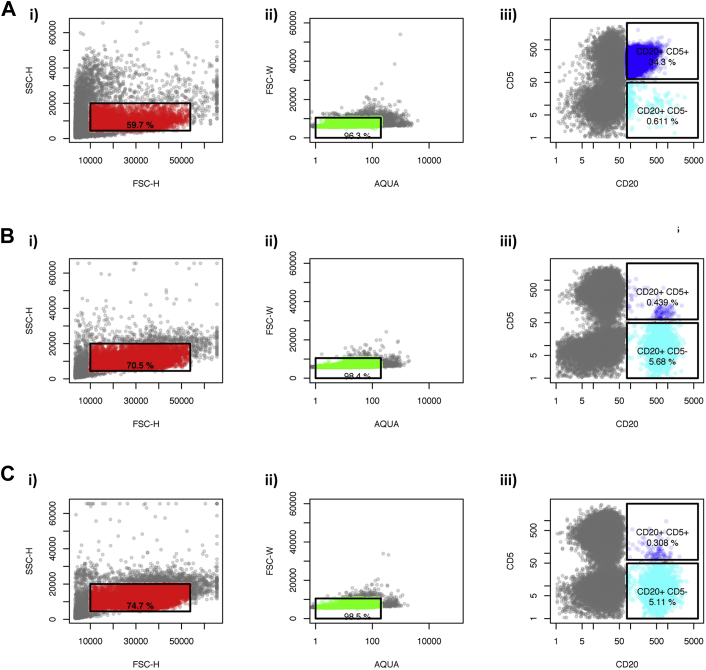
Bulk-cell flow sorting of CD5high and CD5low B cells. The gating strategy used for identification of CD5high and CD5low mature peripheral blood B cells in the bulk-cell experiments for (A) CLL patient 4, (B) healthy individual 3, and (C) healthy individual 4. After exclusion of debris using light scatter features of leukocytes (panels (i)) and exclusion of dead cells (panels (ii)), mature B cells were identified as CD20+ (panels (iii)). Events captured in the dark-blue gate in panels (iii) were identified as CD5high, and those captured in light-blue gate were identified as CD5low.